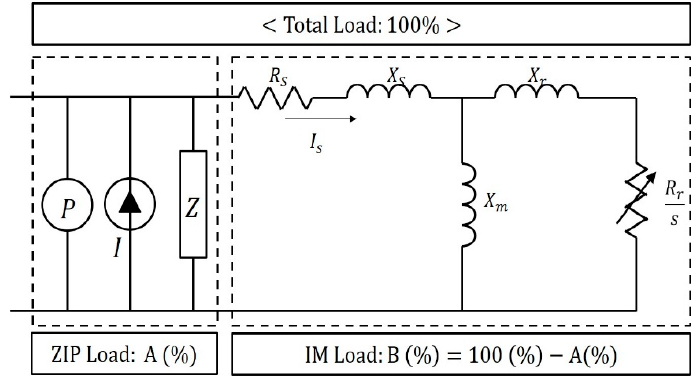
Figure 4. Proportion of the ZIP and IM load.